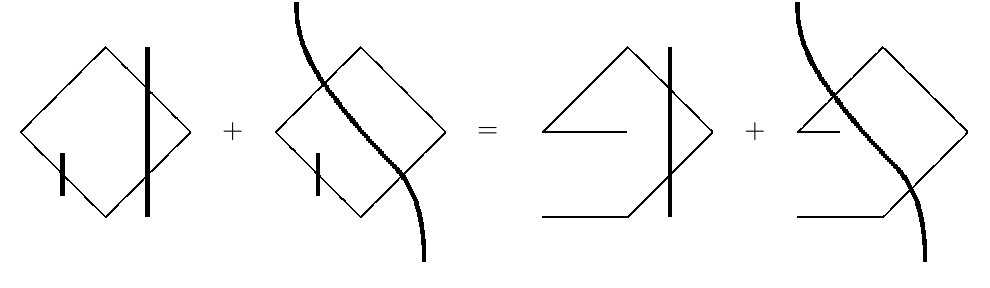
Figure 7 . Contributions to A (1) lous